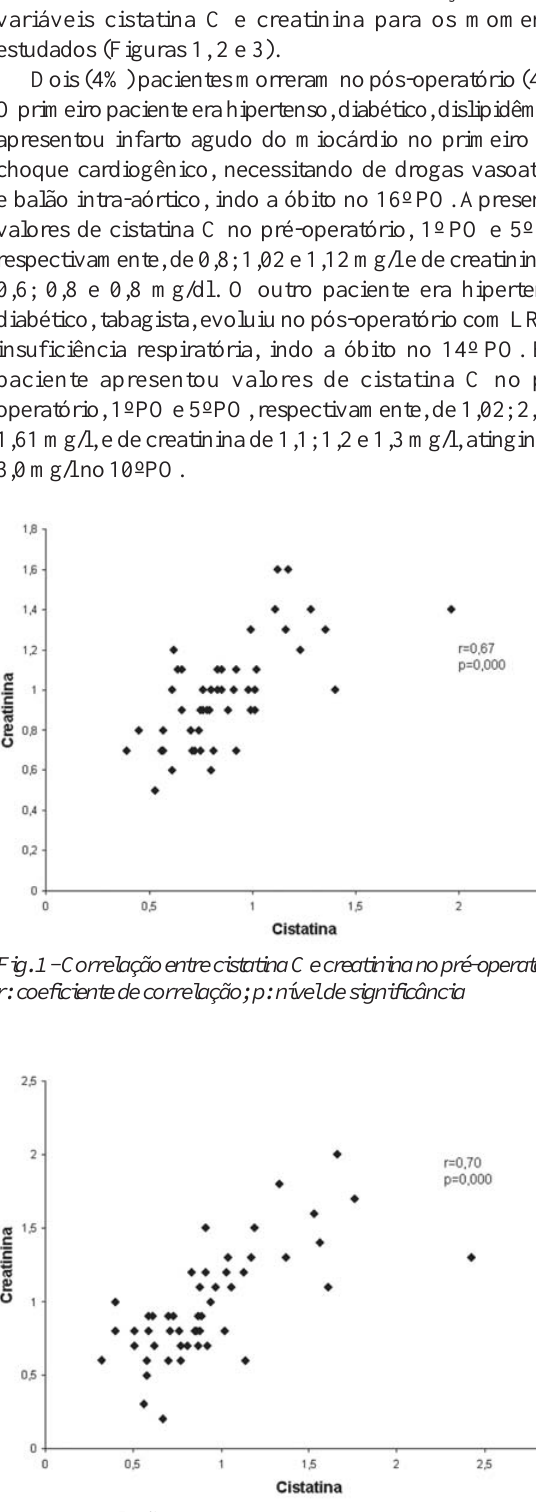
Fig. 2 - Correlação entre cistatina C e creatinina no primeiro pós- operatório; r: coeficiente de correlação; p: nível de